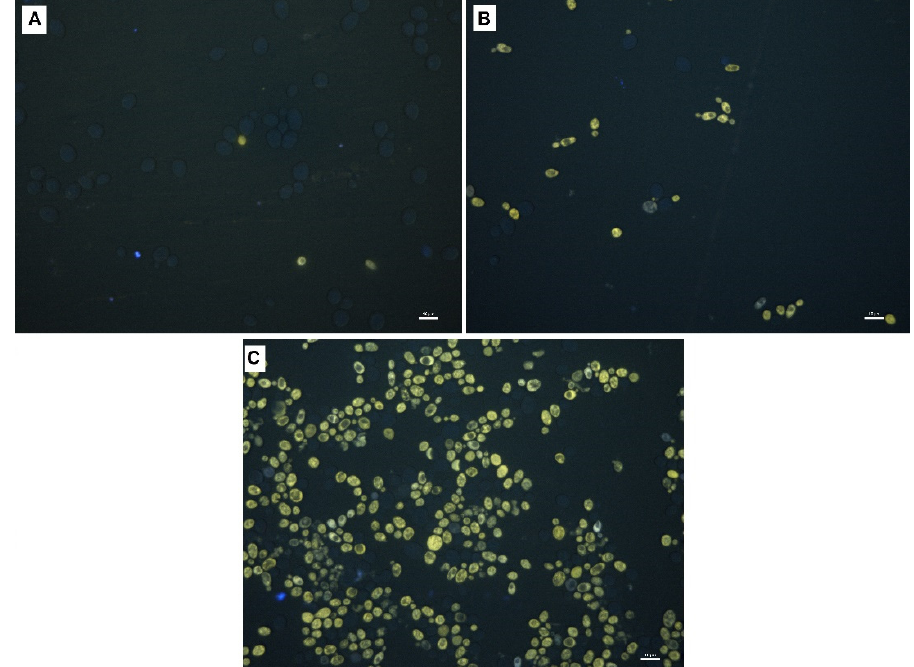
Figure 7. Fluorescent microscopy images of yeasts stained with Rhodamine B: ( A ) C1—control culture without iron ions added to the medium and PEF treatment, ( B ) C2—control culture with iron ions added to the medium (200 µ g/mL) and without PEF treatment, ( C ) culture with iron added to the medium (200 µ g/mL) and PEF treatment (ferric nitrate, voltage 1500 V, pulse width 10 µ s, treatment time 20 min, 1200 pulses, after 20 h of cultivation). The scale bars correspond to 10 µ m.